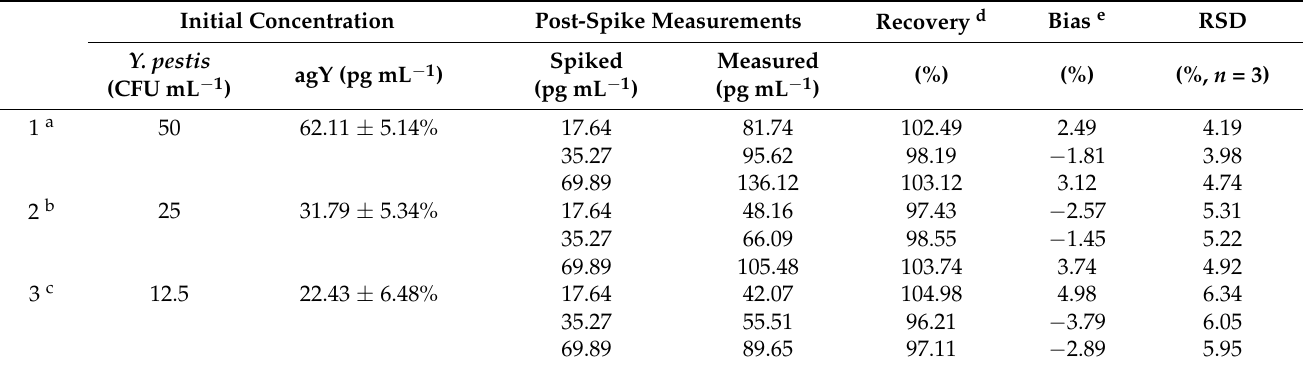
Table 3. Results of recovery tests performed for trinary spiked samples using the reflectance spectra of SPHR